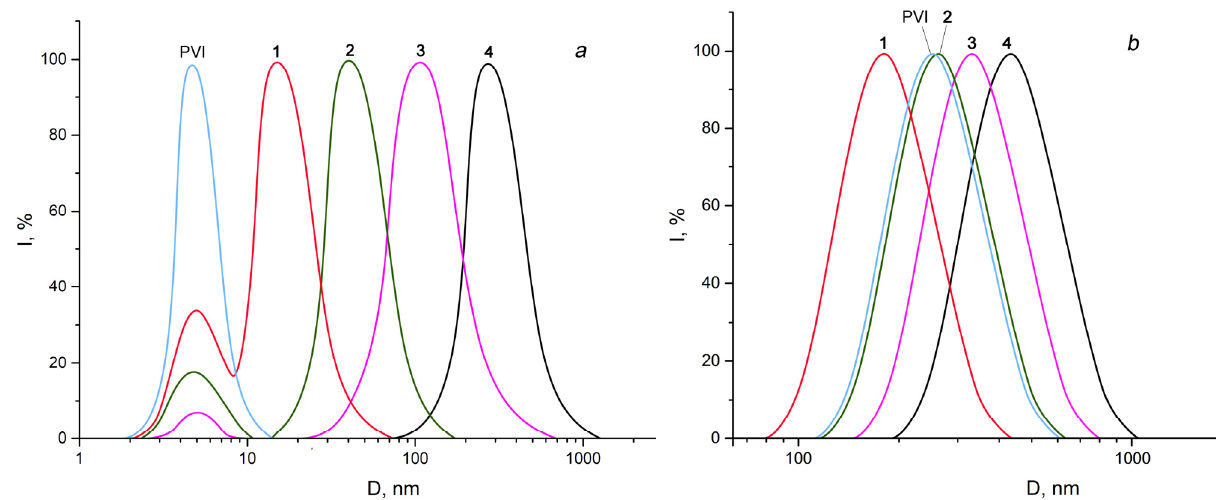
Figure 6. Histogram of the distribution of scattering particles over hydrodynamic diameters for PVI and nanocomposites 1–4 in an aqueous-salt solution ( a ) and in water ( b ).